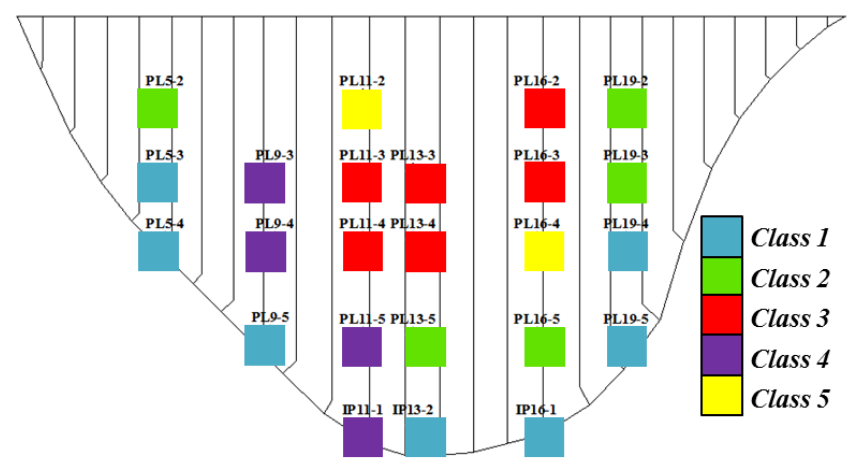
Figure 9. Map of measuring points indicated clustering results.